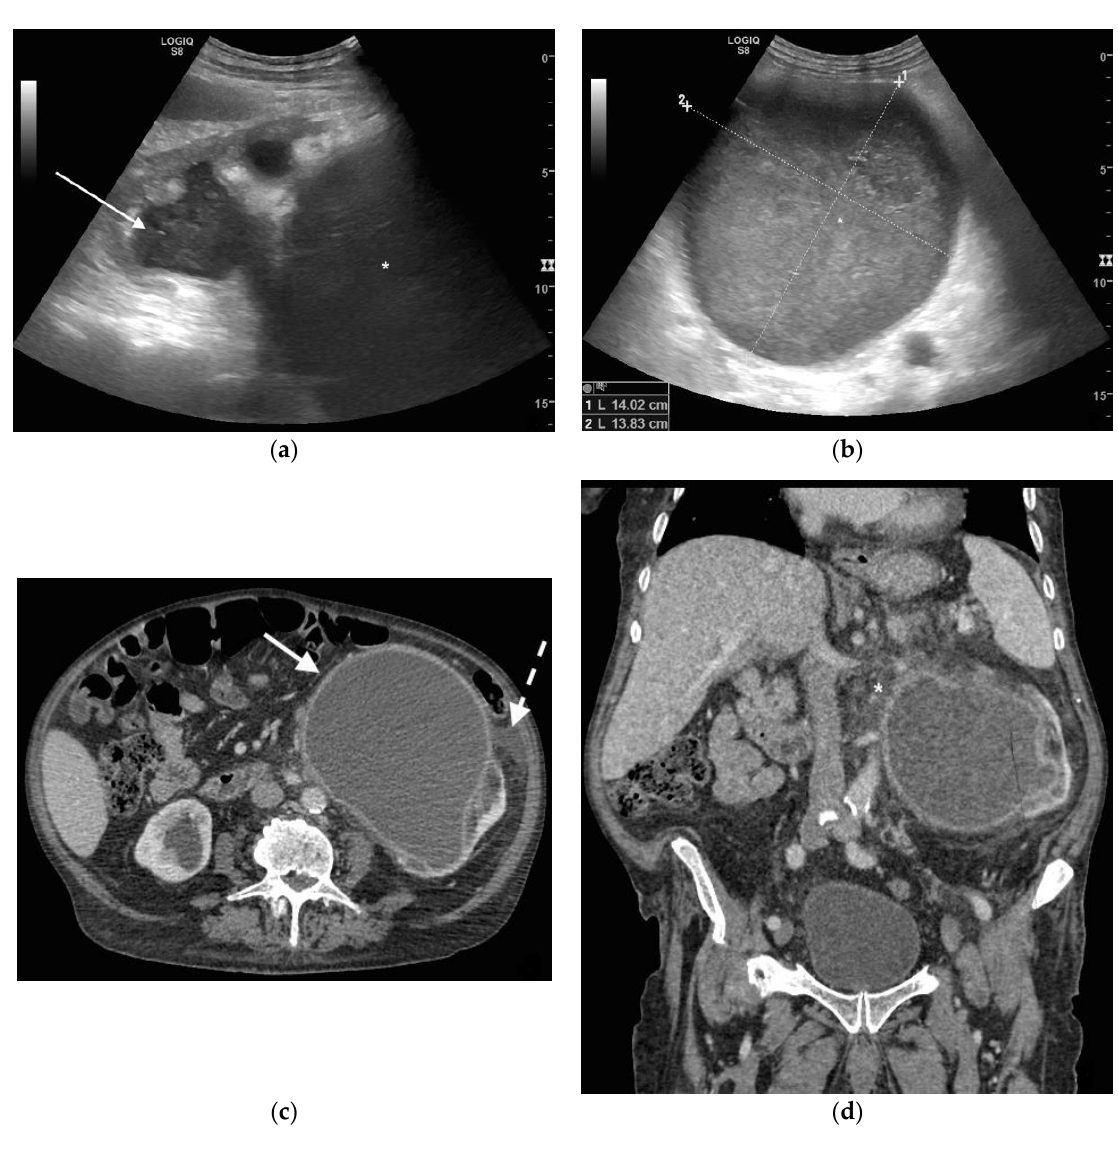
Figure 1. A 78 years old septic male patient. Ultrasound (US) longitudinal ( a ) and axial ( b ) view of the left kidney showing high-grade hydronephrosis with gross dilatation of the renal pelvis and calyces, filled by inhomogeneous urine (white arrow) and an extremely dilated inferior calyceal group filled by a huge ball of debris conglomerate (*). Axial ( c ) and MPR coronal Computed Tomography (CT) ( d ) after intravenous contrast in cortical-medullary phase, showing high grade hydronephrosis, diffuse parietal thickening of the calico-pelvic system (white arrow), fat stranding of perirenal and renal sinus fat. Small amount of free fluid is appreciated anteriorly (dashed arrow).